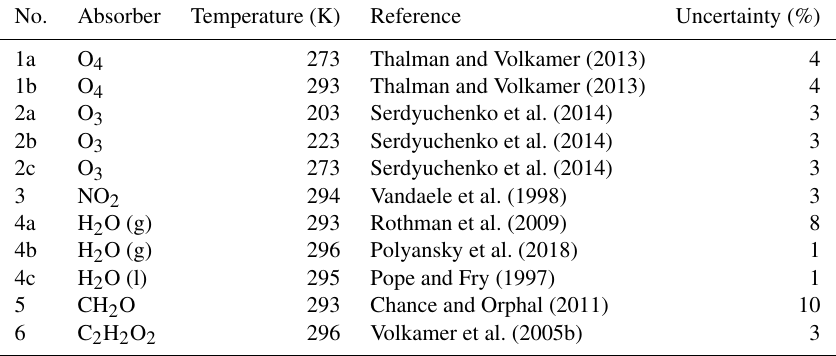
Table 1. Trace gas absorption cross sections used for the spectral retrieval. For H 2 O, gas phase (g) and liquid phase (l), absorption cross sections are used.